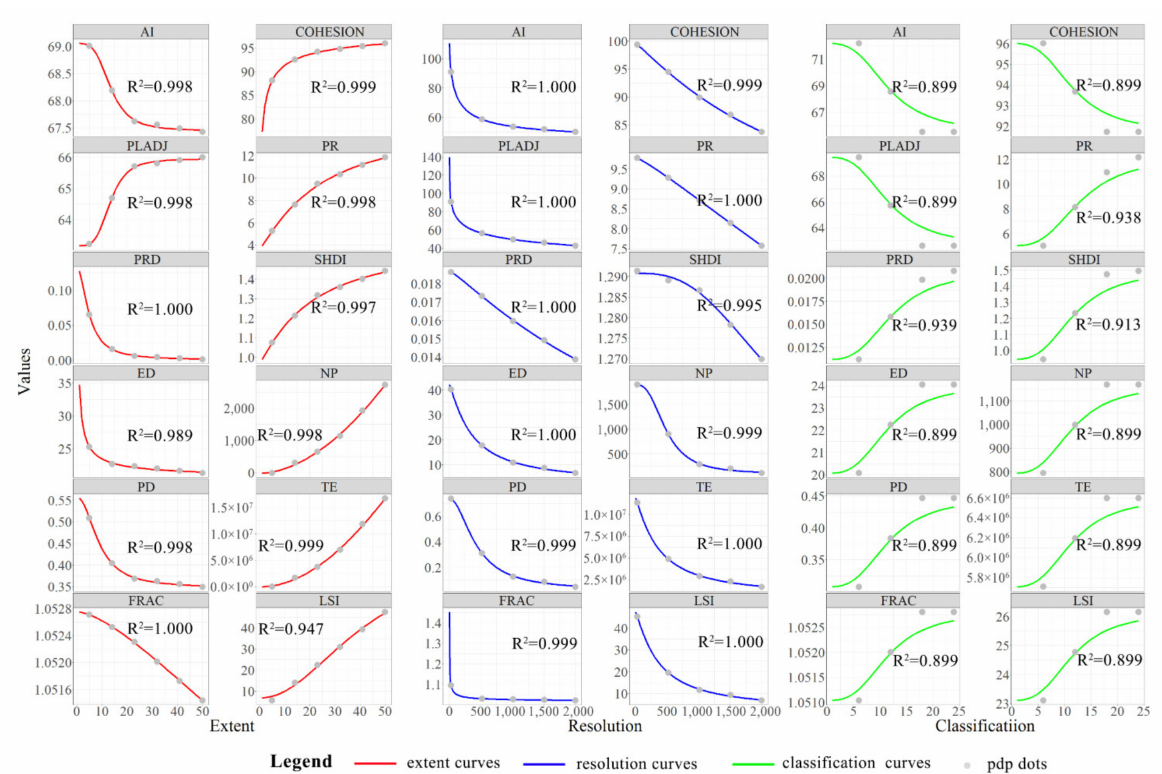
Figure A1. The logistic growth curves of the three single-scale factors.